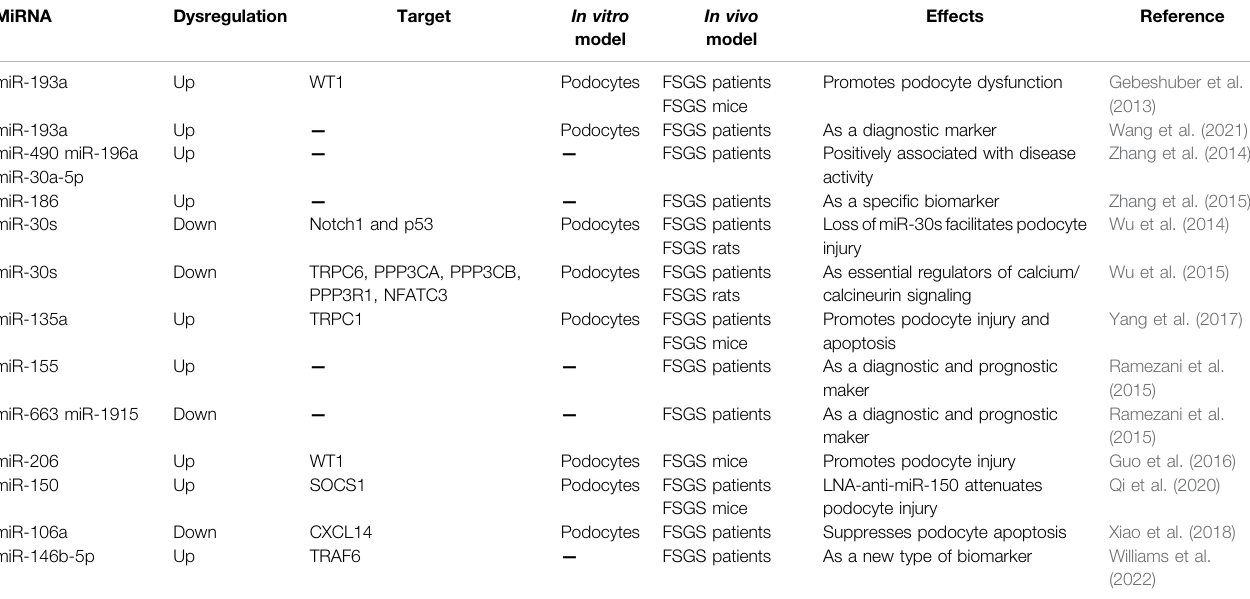
TABLE 1 | MiRNAs in focal segmental glomerulosclerosis.